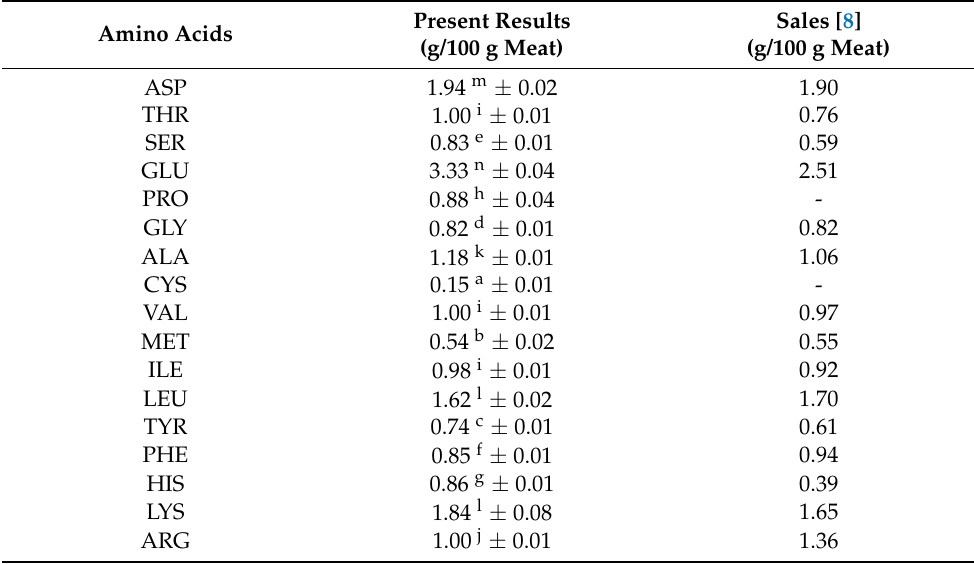
Table 5. Amino acid composition of outside strip ( n = 10) compared to the literature. Amino Acids